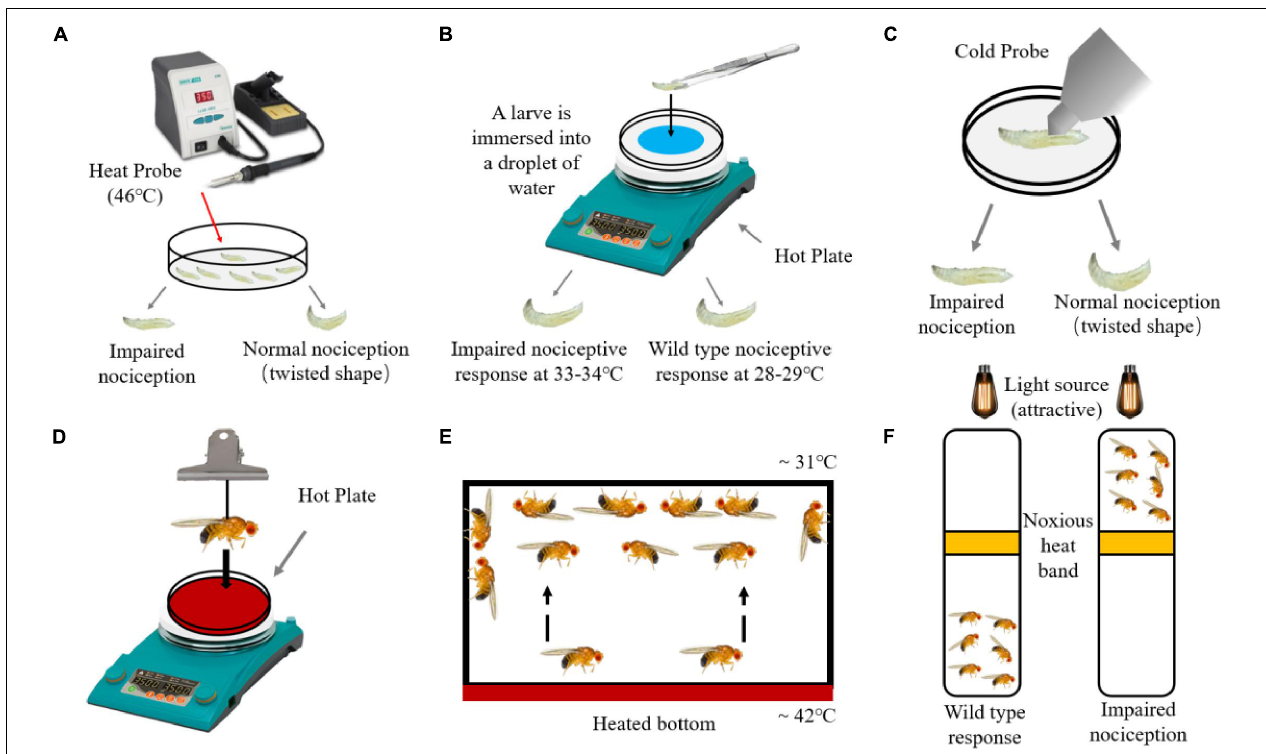
FIGURE 1 | Detection method of harmful temperature nociception in Drosophila . (A) When using a 46 ◦ C heat probe to contact Drosophila larvae, the rolling reaction time of wild-type larvae earlier than the larvae with impaired nociception. (B) Drosophila larvae with impaired nociception and wild-type larvae can cause rolling reaction when placed in water at 33–34 and 28–29 ◦ C respectively. (C) When using a cold probe to contact larvae, the rolling reaction time of wild-type larvae earlier than the larvae with impaired nociception. (D) After keeping the adult flies on a hot plate at 47 ◦ C, record the incubation period of the Drosophila to produce a jumping response. (E) Place the adult flies in a heating device, and wild-type flies will concentrate on the upper part of the device with a suitable temperature. (F) The optical drive heat avoidance test uses a heated aluminum ring as a harmful barrier between the adult Drosophila and the light source